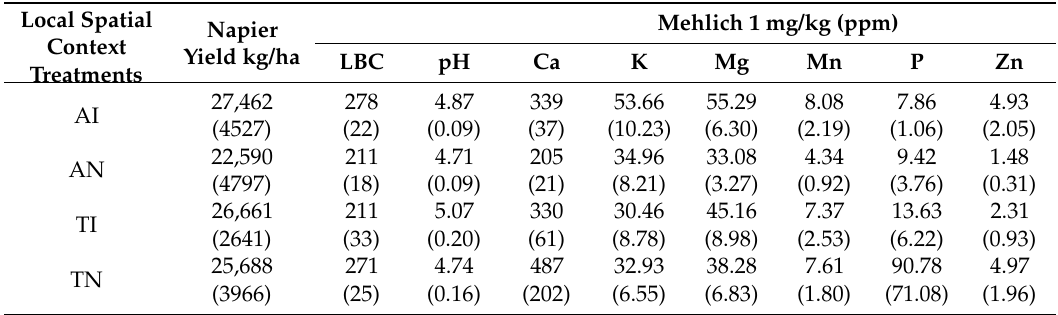
Table 2. Mean ( ± 1 SE) Napier grass yields and soil nutrient levels observed in plots in relation to local spatial context. Notes: adjacent to woodland (T) or agriculture (A); irrigated (I) and not irrigated (N). Lime buffer capacity (LBC) is a measure of the amount of soil acidity that must be neutralized in ppm by pure calcium carbonate to raise the pH by one unit.